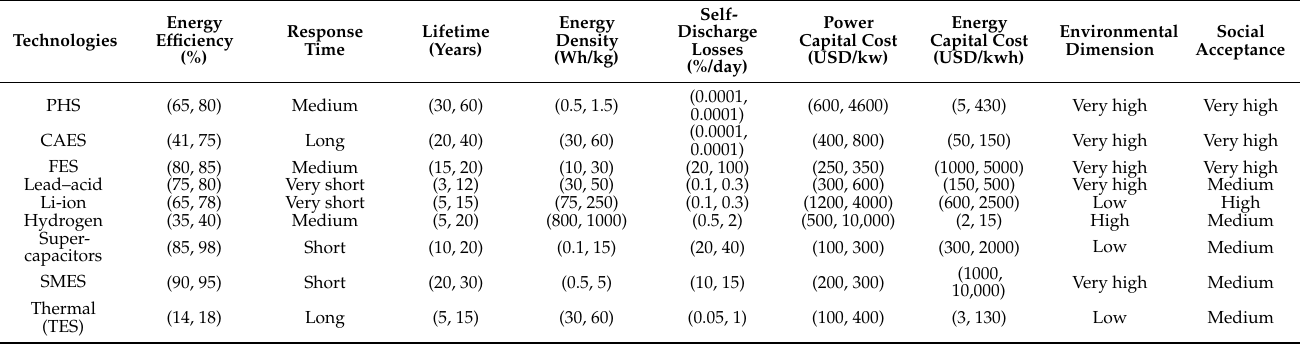
Table A1. Decision basic data of Expert